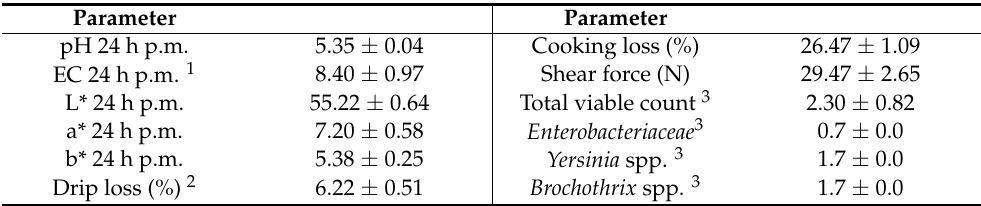
Table 1. Least square mean (LSM) and standard error (SE) values of the quality parameters of pork taken for the study ( n = 6).